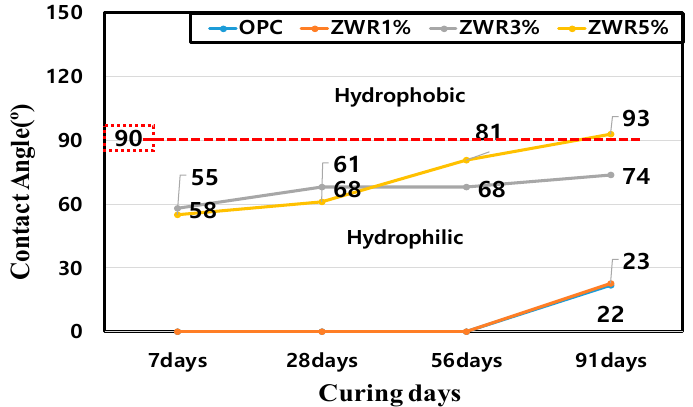
Figure 11. Result of contact angle test 91 days.